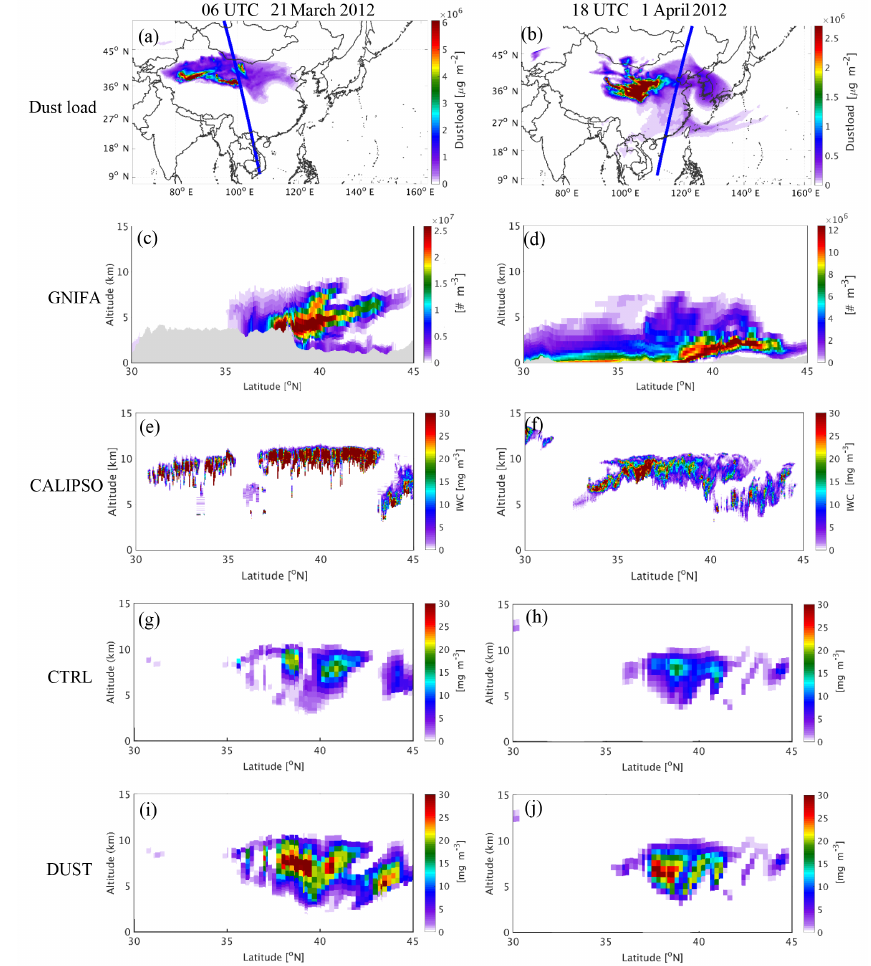
Figure 8. Spatial distribution for simulated dust load and satellite scanning track (a, b) ; the simulated vertical profile of ice-friendly aerosol (GNIFA) number concentration (c, d) , with the orography represented by the shaded area; the CALIPSO vertical profile of IWC (e, f) ; and the simulated vertical profile of IWC from CTRL (g, h) and DUST (i, j) for the case on 21 March (left column) and 1 April (right column) of